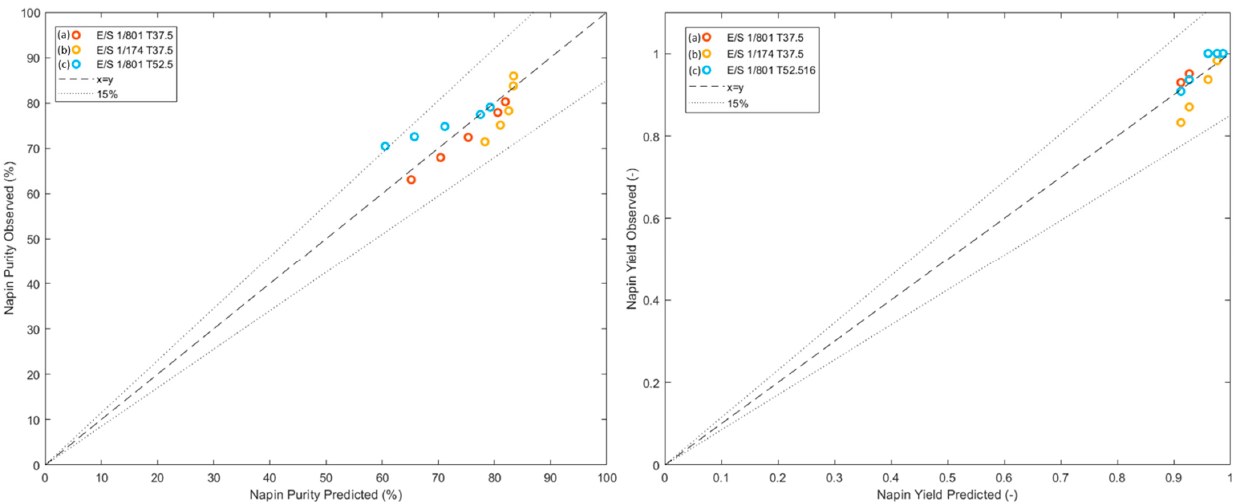
Figure 5. Correlations between experimental and predicted values of napin purity ( left ) and yield ( right ) for predicted kinetics (a, b, and c), and 15% error interval.